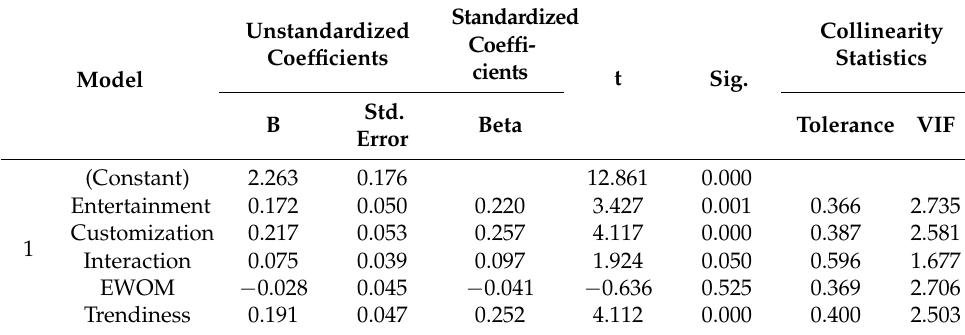
Table 6. Regression 1: Coefficients a .